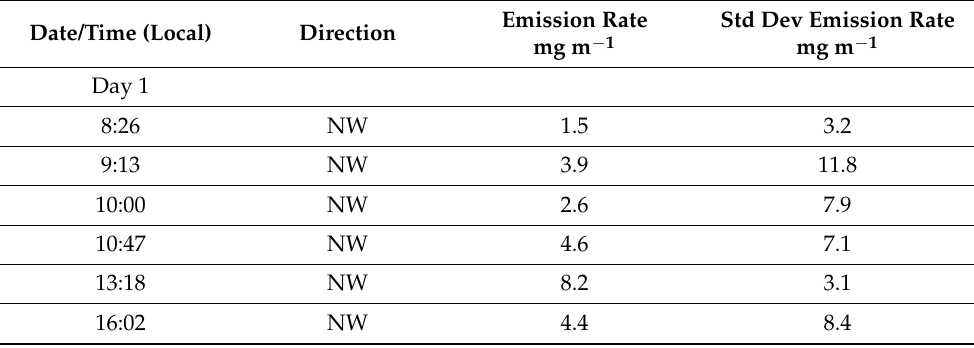
Table 4. SCAMPER PM 10 pass-averaged emission rate data for the haul truck for each direction of each test